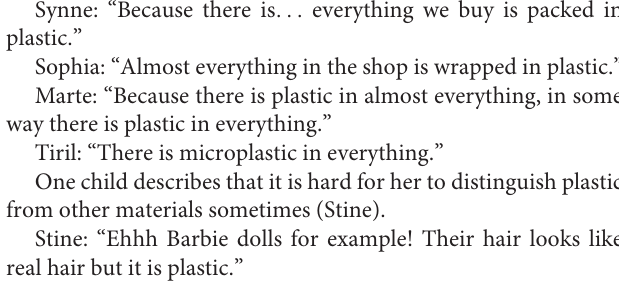
Perceptions of Plastic Pollution The theme that emerged the